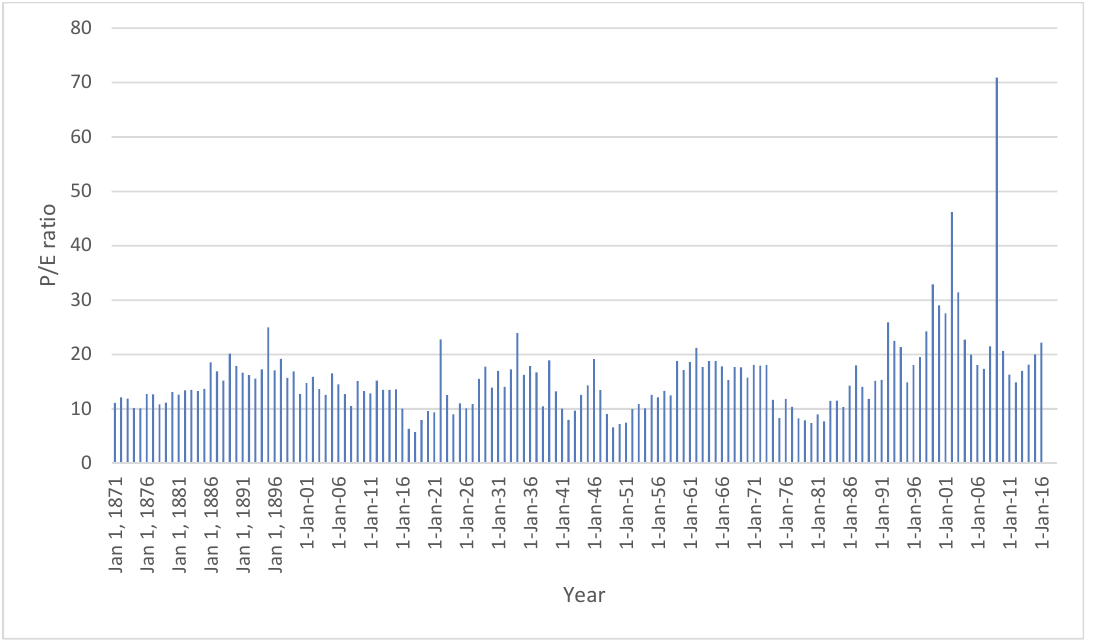
Fig. 1. Average P/E ratio of S&P 500 from 1871 to